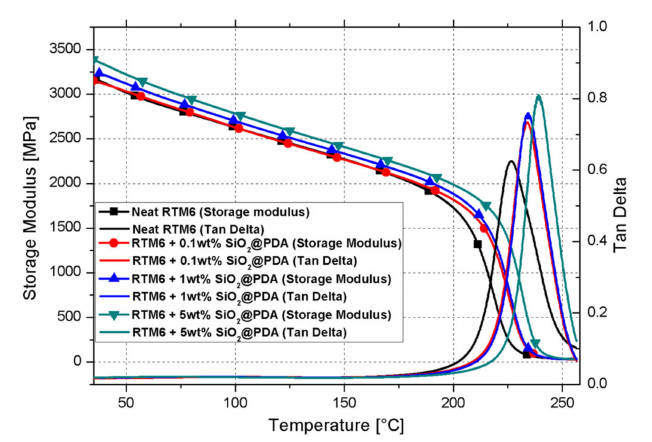
Figure 8. Dynamic mechanical analysis (DMA) curves of neat epoxy and SiO 2 @PDA / RTM6